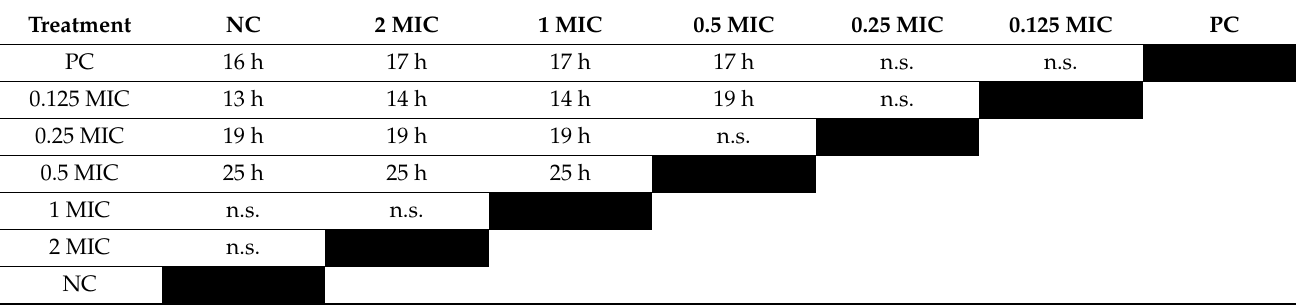
Table 3. Significant growth delay of S. cerevisiae over time of 0.125 minimal inhibitory concentration (MIC; 0.02 µ L mL − 1 ) of (0.25 µ L mL − 1 ) compared to negative control without cells and positive control without treatment with CA in triplicates ( n = 3). OD 620 measurements over time (in hours) were carried out and significant differences ( p < 0.05) between different treatments according to one-way analysis of variance (n.s. = not significantly different after 48 h) denoted.